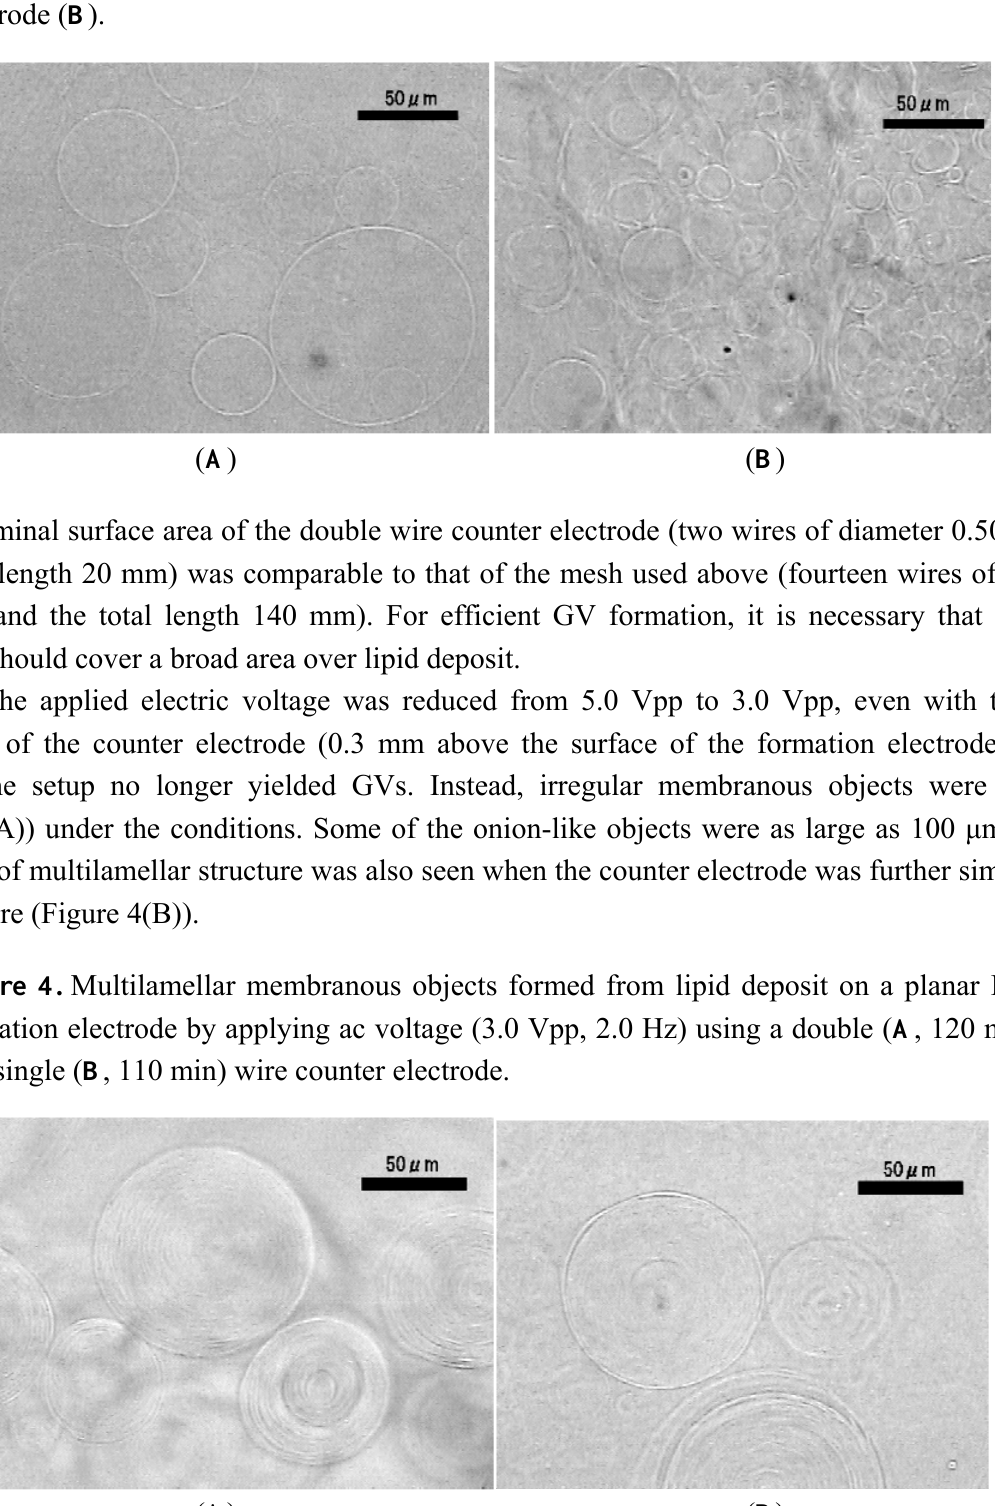
Figure 3. GVs formed from lipid deposit on a planar electrode directly under a double wire counter electrode ( A , 100 min) upon application of ac voltage (5.0 Vpp, 2.0 Hz).